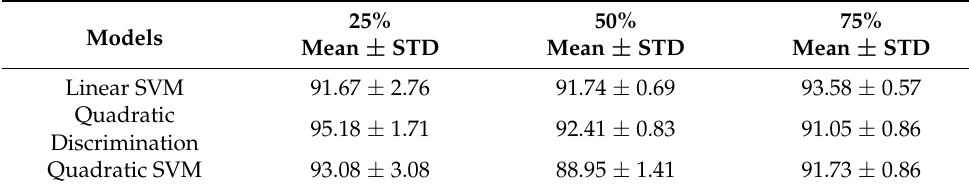
Table 3. Scenario 2 best